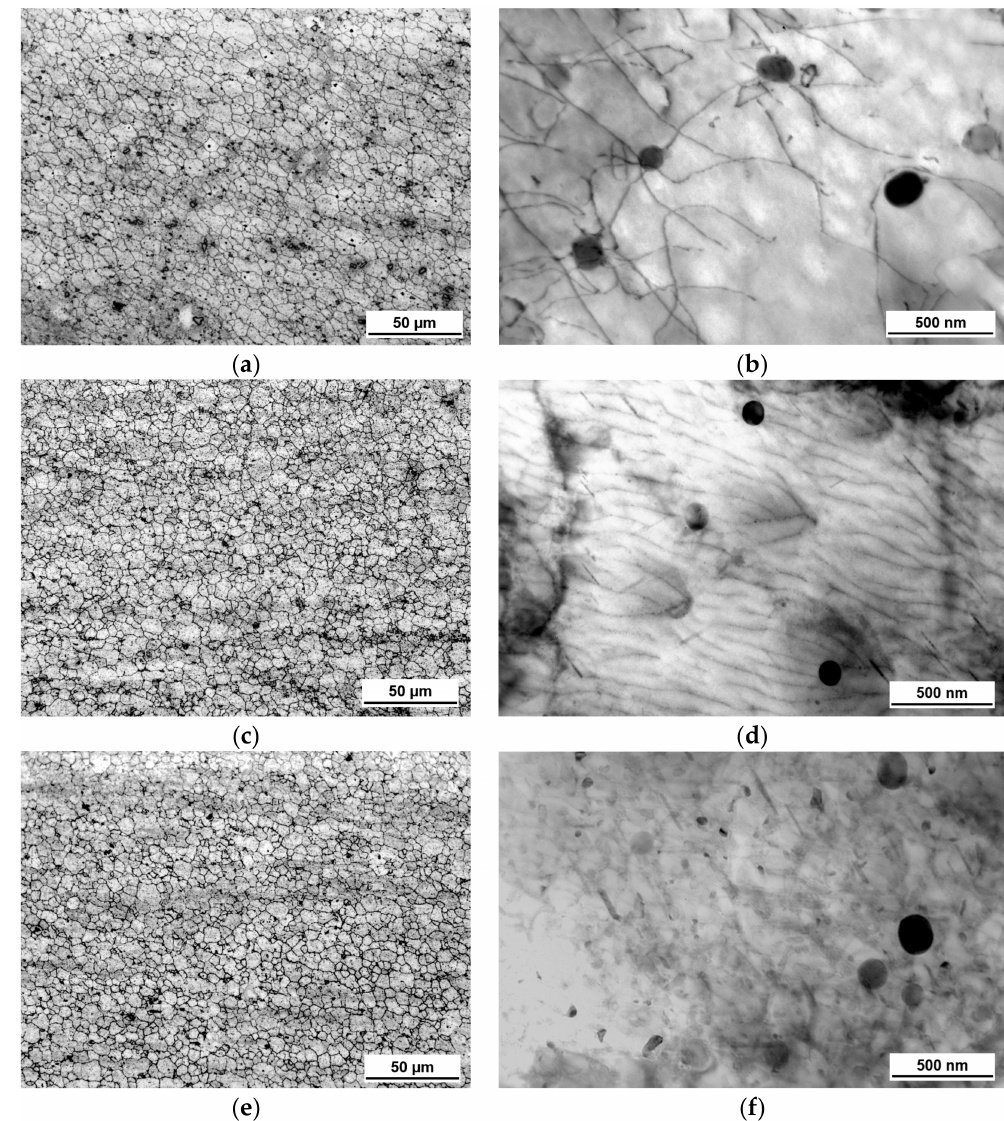
Figure 3. Microstructure in Stir Zone FSW weld ( a ) optical image; ( b ) TEM image; IFSW 2 kN 3 Hz weld ( c ) optical image; ( d ) TEM image; IFSW 2 kN 10 Hz weld; ( e ) optical image; ( f ) TEM